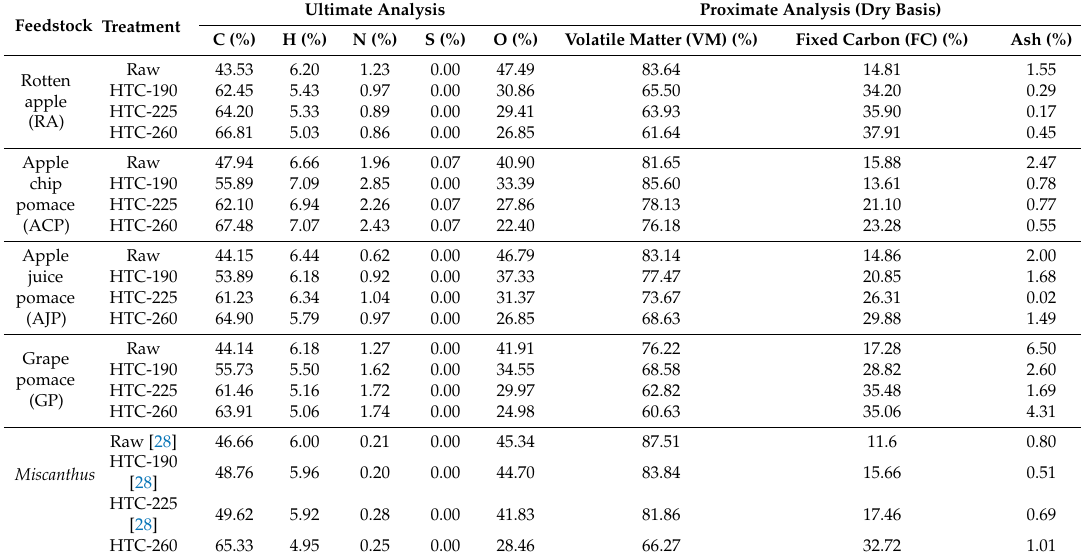
Table 1. Results of proximate and ultimate